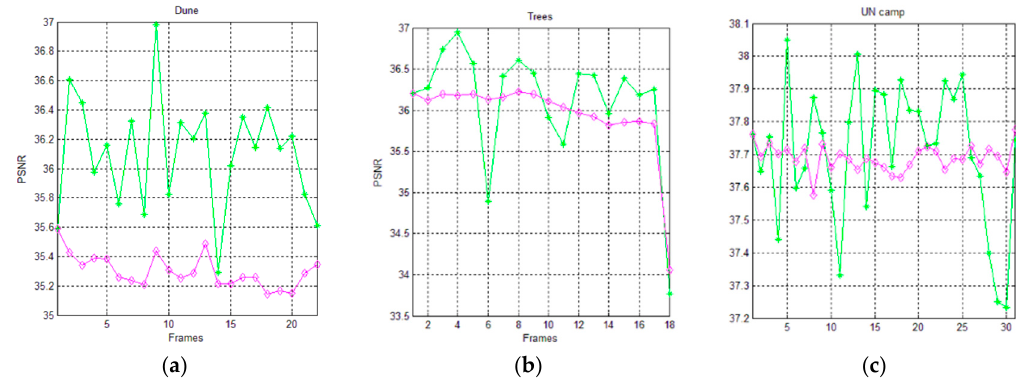
Figure 13. Graphical comparison of the achieved PSNR between the AVQ algorithm (green line) and the AVQ IS algorithm (magenta line), by using a dictionary of 4096 (2 12 ) entries, for ( a ) the Dune sequence; ( b ) the Trees sequence; and ( c ) the UN camp sequence.